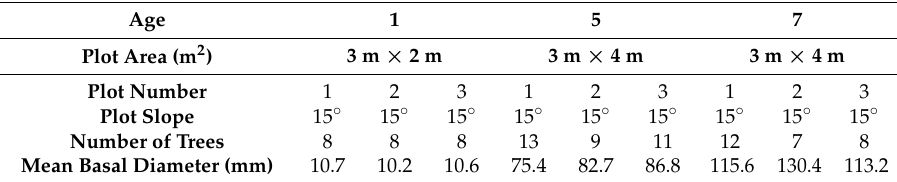
Table 1. Basic conditions of various growth years.